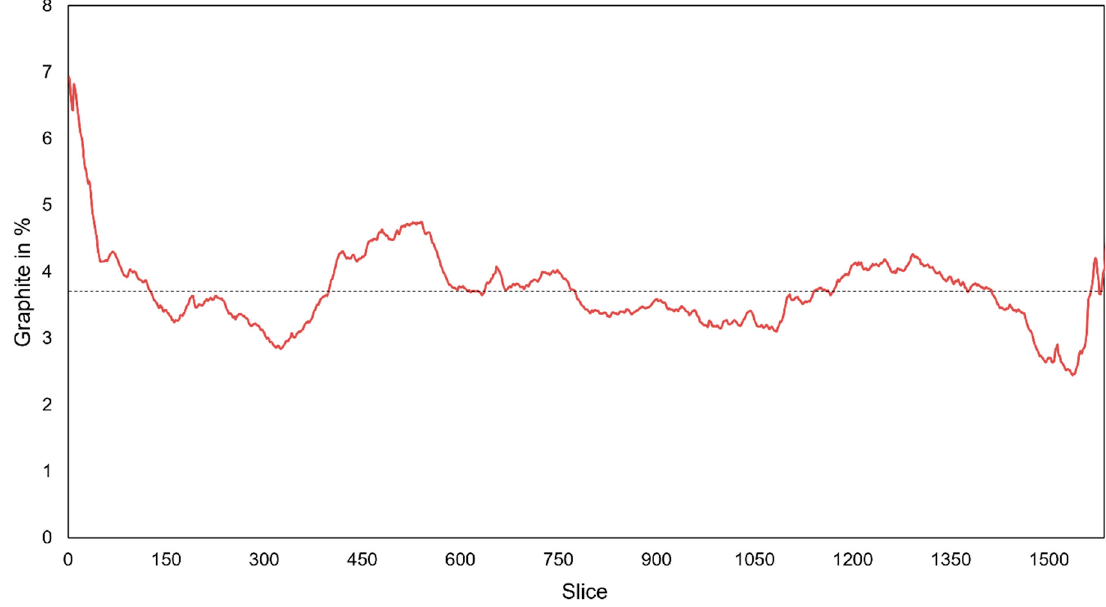
Figure 9. Graphite content per slice of the cylindrical subvolume. The dashed horizontal line represents the average graphite concentration of 3.7%.